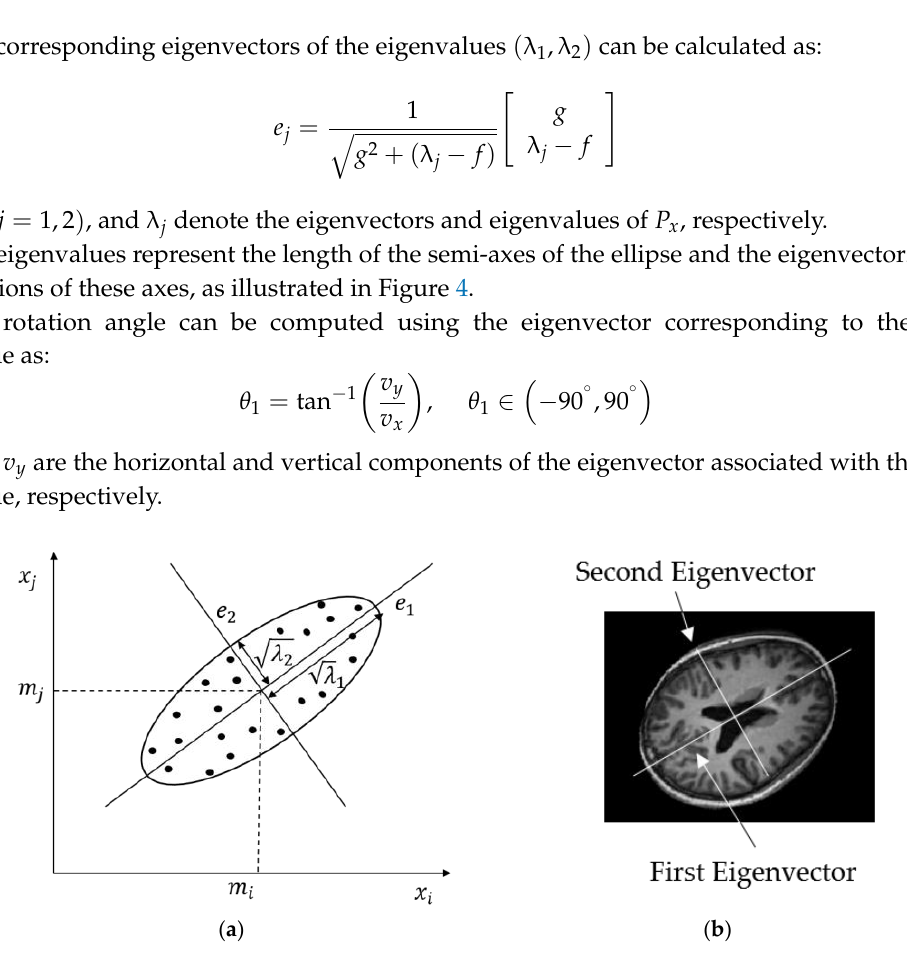
Figure 4. Orthonormal eigenvector by principal component analysis (PCA). ( a ) Eigenvector e 1 through the center of the elliptical area represents the maximum variance and e 2 is perpendicular to e 1 , and ( b ) extracted eigenvectors from brain brain magnetic resonance images (MRI) are imposed on the image.